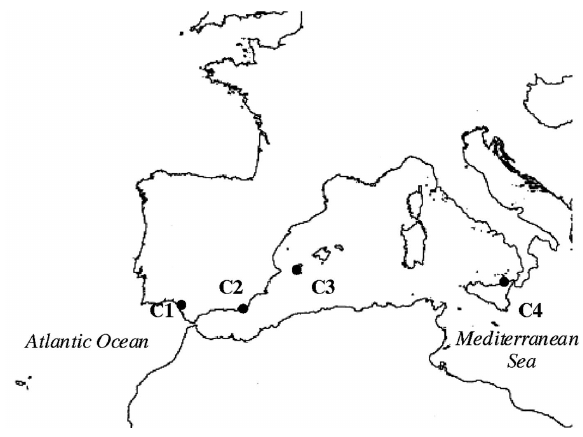
Fig . 1. – Geographic locations of coastal sampling stations.